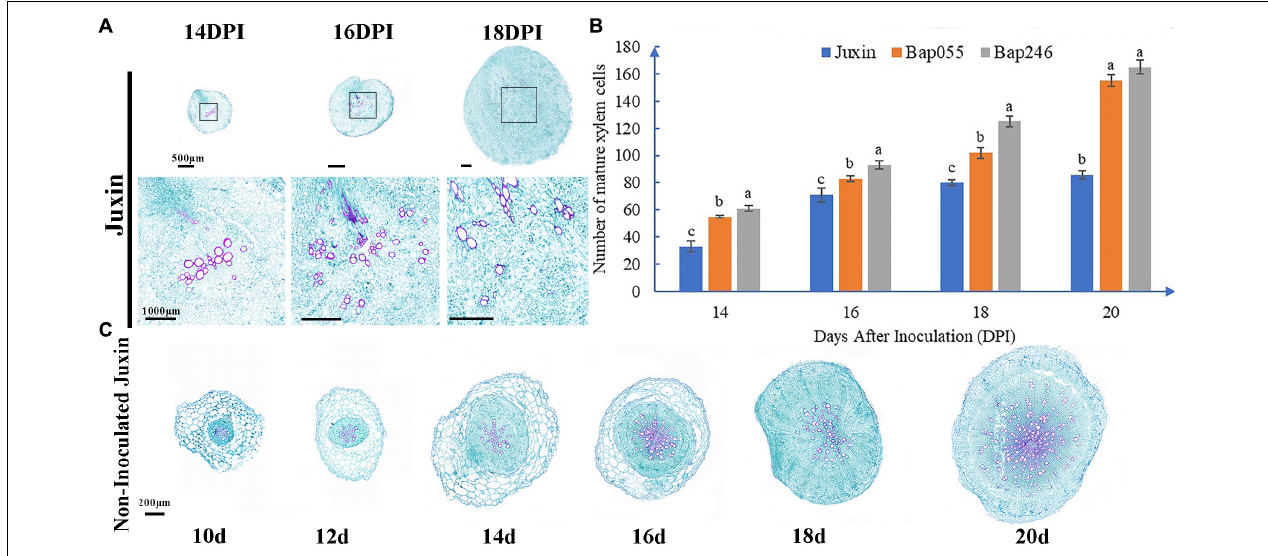
FIGURE 8 | Changes of root of “Juxin” in secondary infection stage at 14–20 days post-inoculation (DPI). (A) Root sections of the clubroot susceptible Chinese cabbage host “Juxin” at 14–18 DPI with P. brassicae . The roots of “Juxin” were disrupted from 16 DPI. The areas highlighted within the black boxes are enlarged for more detail. (B) Number of mature xylem cells in “Juxin,” Bap055, and Bap246 at 14–20 DPI. The formation of new xylem was inhibited from the onset of gall formation from 16 DPI onward of “Juxin.” (C) Root sections of non-inoculated “Juxin” at 10–20 DPI. The root grows normally without structural change. Different letters on the same color bars indicate significant difference at P < 0.05 level by LSD